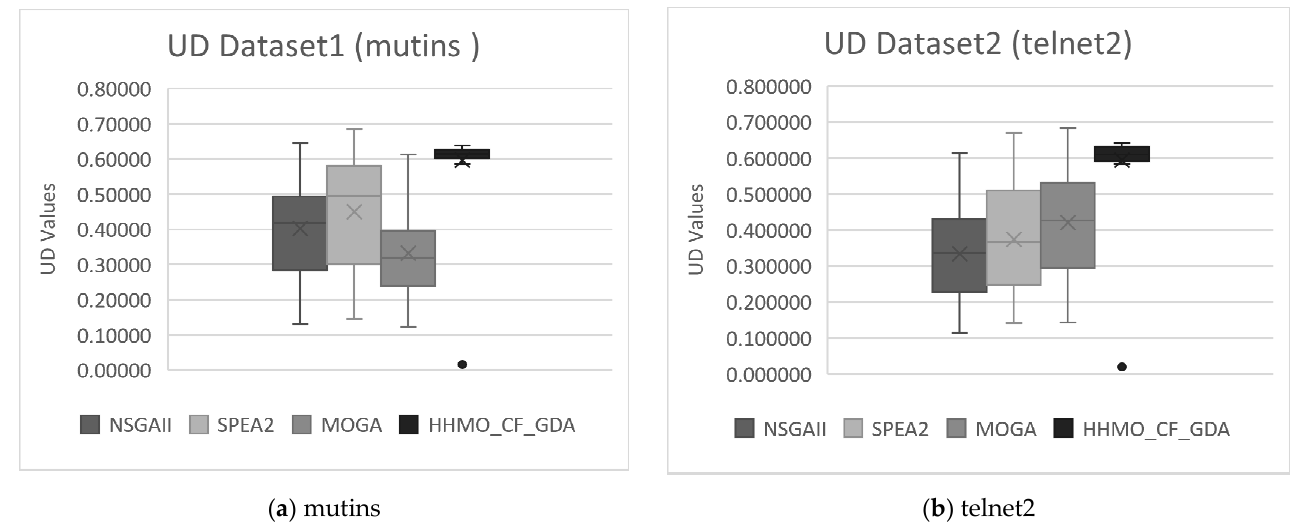
Figure 5. Box plots of NSGAII, SPEA2, MOGA, and HHMO_CF_GDA of uniform distribution (UD) on the mutins and telnet2 datasets: ( a ) mutins box plots; ( b ) telnet2 box plots.